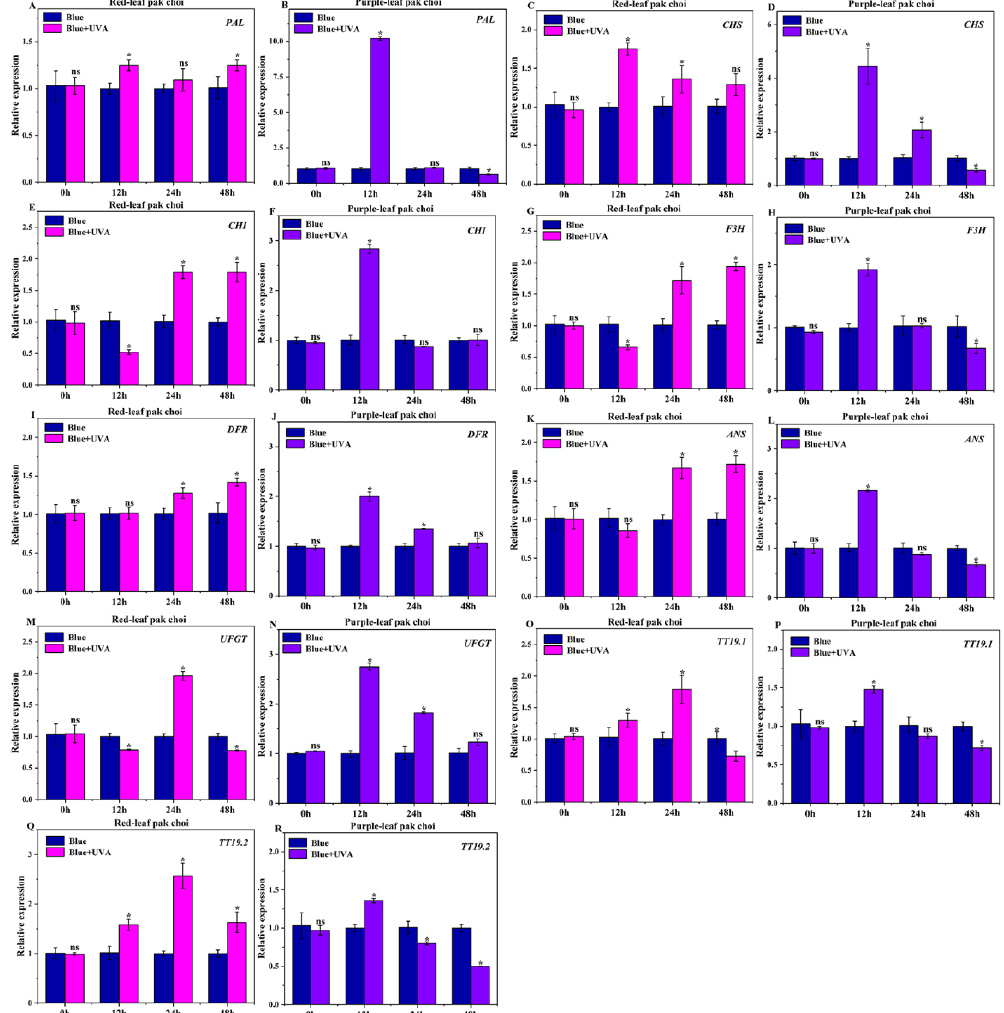
Figure 9. qRT-PCR analysis results of anthocyanin structural genes in red- and purple-leaf pak choi. These genes were abbreviated as follows: phenylalanine ammonia lyase ( PAL ) of red- ( A ) and purple-leaf ( B ) pak choi; chalcone synthase ( CHS ) of red- ( C ) and purple-leaf ( D ) pak choi; chalcone isomerase ( CHI ) of red- ( E ) and purple-leaf ( F ) pak choi; flavanone 3-hydroxylase ( F3H ) of red- ( G ) and purple- leaf ( H ) pak choi; dihydroflavonol 4-reductase ( DFR ) of red- ( I ) and purple-leaf ( J ) pak choi; anthocyanidin synthase ( ANS ) of red- ( K ) and purple-leaf ( L ) pak choi; UDP-glucose flavonoid 3-O-glucosyltransferase ( UFGT ) of red- ( M ) and purple-leaf ( N ) pak choi; transparent testa19.1 ( TT19.1 ) of red- ( O ) and purple-leaf ( P ) pak choi; transparent testa19.2 ( TT19.2 ) of red- ( Q ) and purple-leaf ( R ) pak choi. Detection of quantitative RT-PCR analysis at four time points under blue and blue + UVA light continuous illumination for 48 h. ‘ns’ means non-significant and ‘*’ represents statistically significant differences ( p < 0.05). Error bars indicate ± SE ( n = 3).